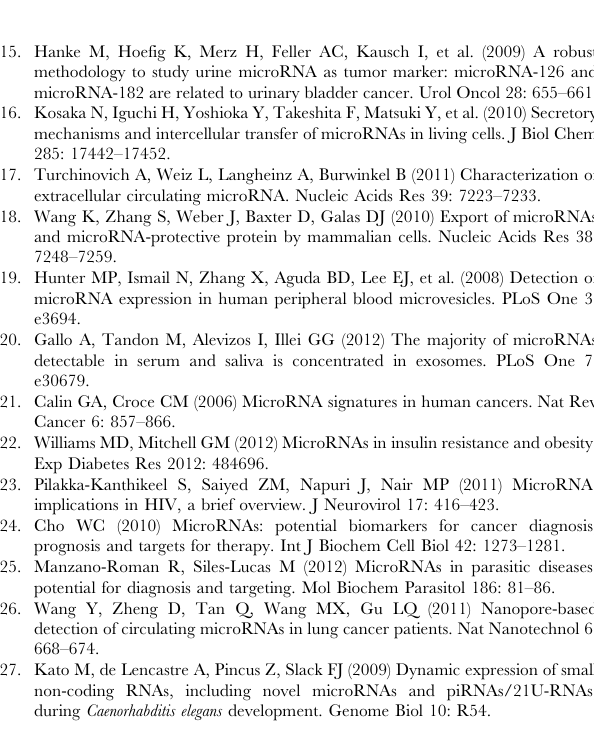
Table S3 D. immitis miRNA candidate sequences identified by deep-sequencing from a co-infection with hookworm. Table S4 Overlapping unknown D. immitis predicted candidates